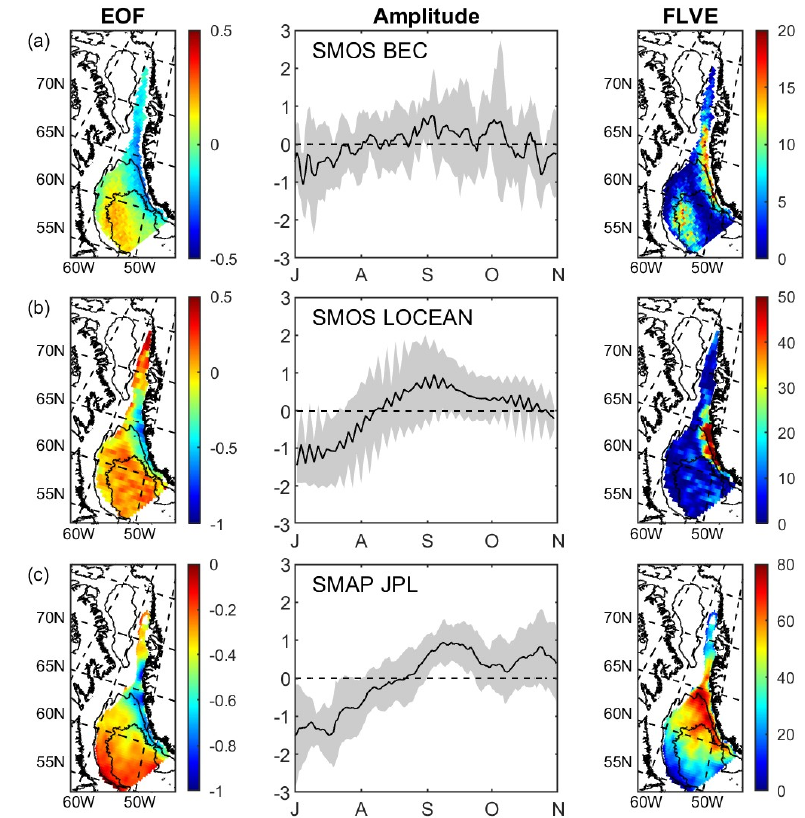
Figure 5. Empirical orthogonal function (EOF) decomposition of surface salinity observations from ( a ) (top panels) SMOS BEC; ( b ) (middle panels) SMOS LOCEAN; ( c ) (bottom panels) SMAP JPL. (Left) spatial pattern; (middle) amplitude time series; (right) fraction of local variance explained (FLVE; %) are shown. Only observations from July to October were used in the analysis. For each product, the amplitude time series is displayed as the average (black line) for the multiple years, with the gray shaded area showing the standard deviation between the years. Note that color bars vary between the panels to reveal as much as possible of the spatial structure in each case.